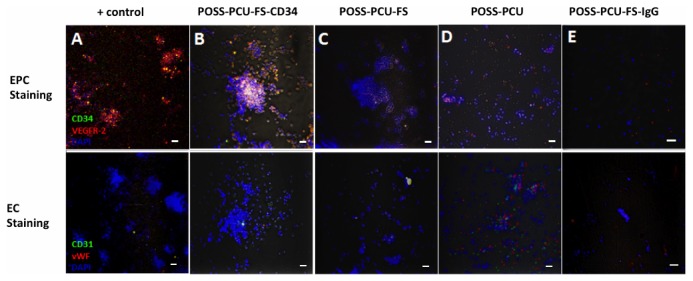
EPC capture assay.Cells were double-stained at day 7 for either EPC (CD34/VEGFR-2) or EC (CD31/vWF) markers, and counterstained with DAPI for nuclei. (A) Positive control, (B) POSS-PCU-FS+CD34, (C) POSS-PCU-FS, (D) POSS-PCU, (E) POSS-PCU-FS+IgG isotype negative control (20x magnification). Scale bar represents 20 µm.POSS-PCU-FS: POSS-PCU with fumed silica anchors, POSS-PCU-FS+CD34: POSS-PCU biofunctionalized with anti-CD34 antibodies, POSS-PCU-FS+IgG: POSS-PCU biofunctionalized with goat anti-mouse antibodies.